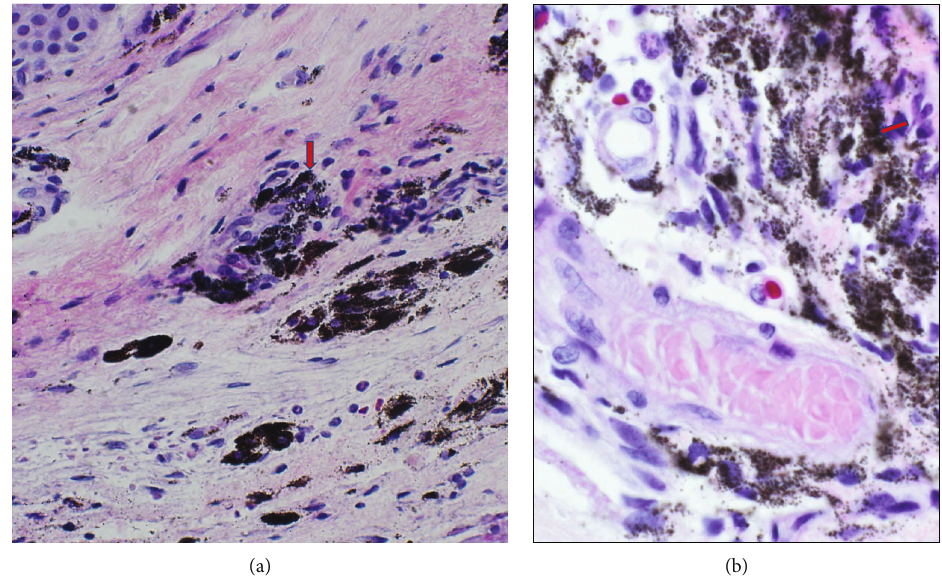
Figure 4: (a) Showing light microscopy and (b) higher magni fi cation with intracellular pigments and stromal pigments